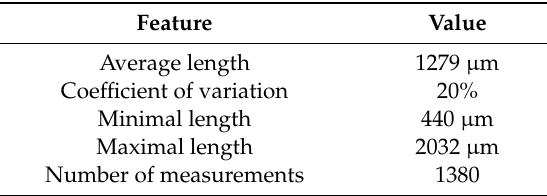
Table 3. Characteristics of fiber length.